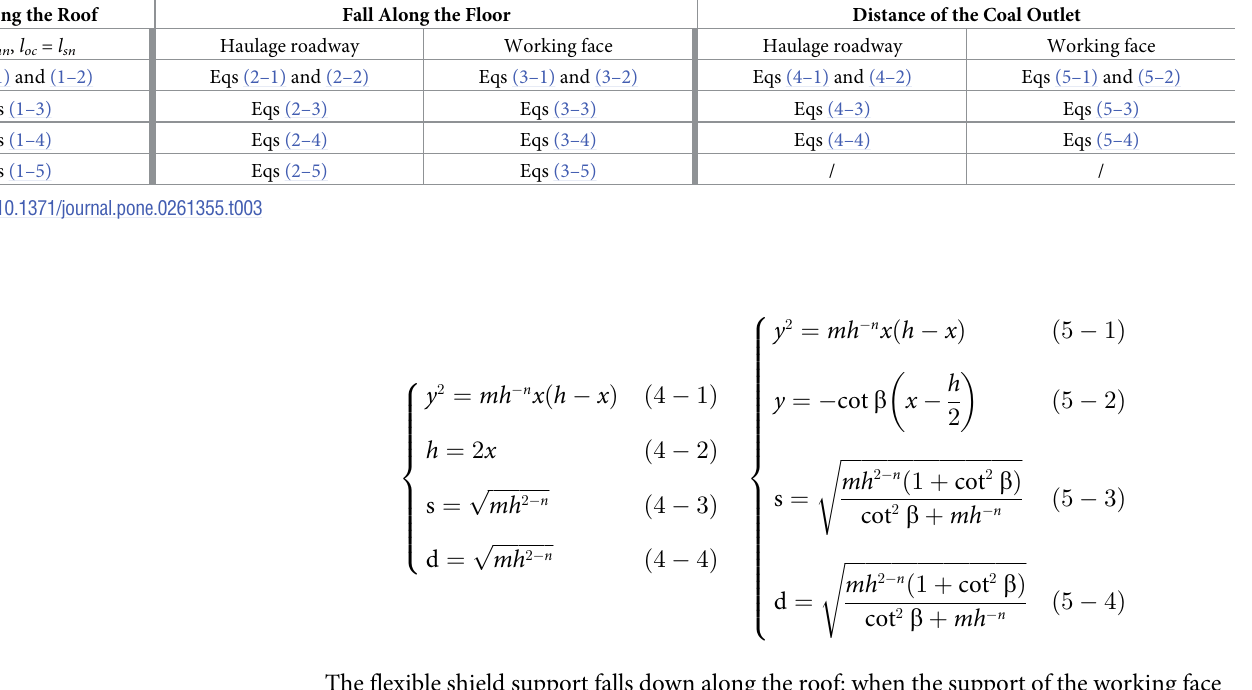
ð 4 (cid:0) 3 Þ ð 4 (cid:0) 4 Þ